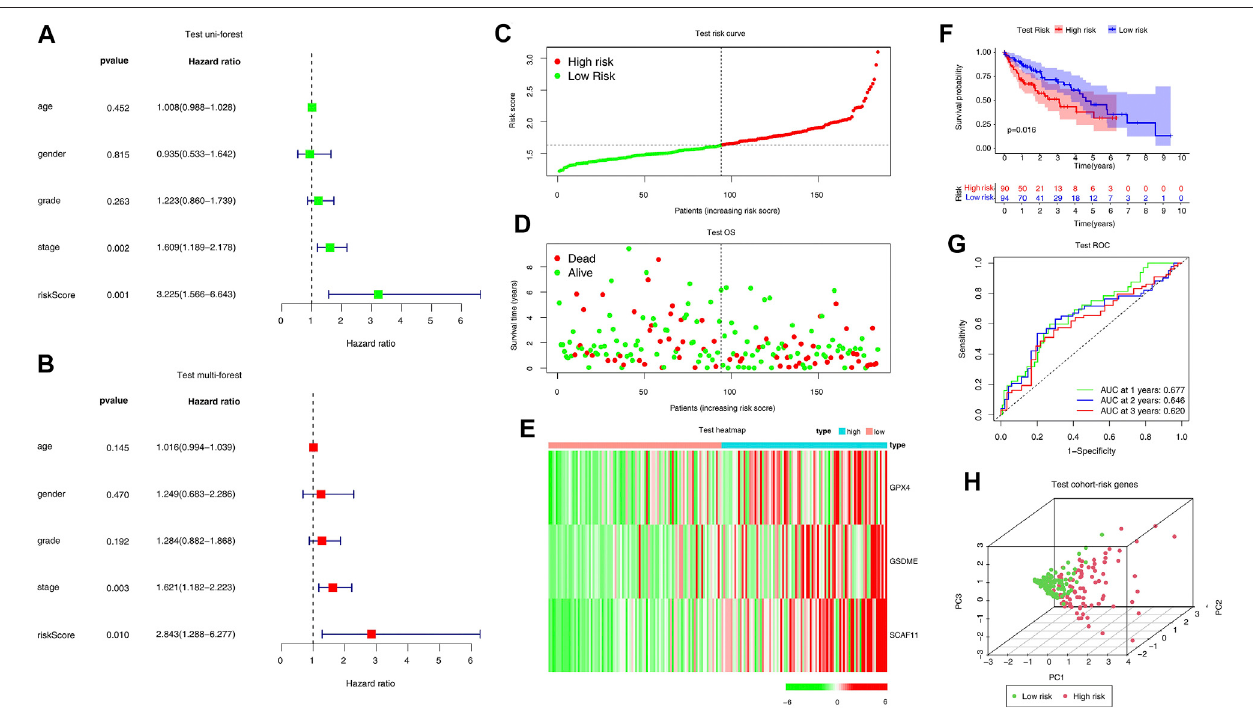
FIGURE 4 | Internal validation of the risk model in the TCGA test cohort. (A, B) Forest plots of Univariate Cox analysis and Multivariate Cox analysis. (C – E) Distributionofriskscores,survivalstatus,andexpressionofthethreepyroptosis-relatedriskgenes. (F) TheKManalysisoftheoverallsurvivalinthehigh-riskandlow-risk groups. (G) The ROC analysis to estimate the predictive ef fi ciency. (E) Univariate analysis. (H) PCA analysis of the high-risk and low-risk groups based on the three risk